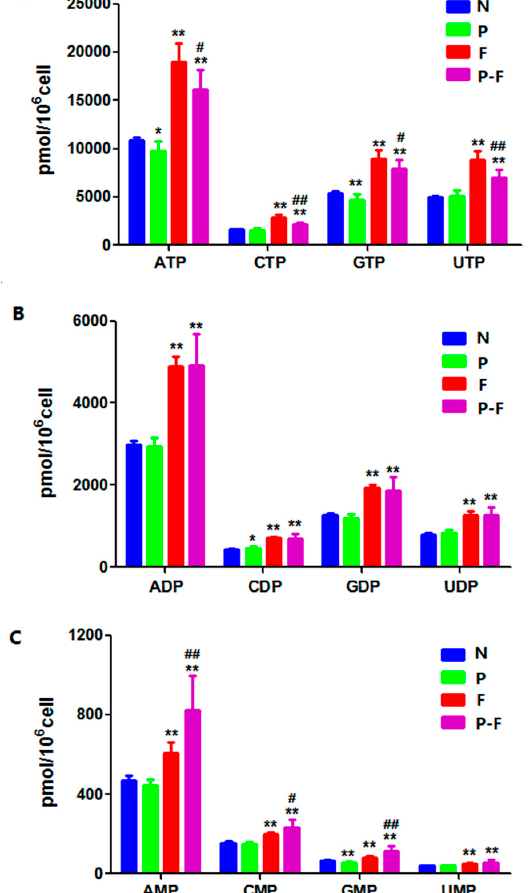
Figure 3. Levels of ribonucleotides in HepG2 cells after treatment with drugs for 24 h: ( A ) nucleoside triphosphate levels in every group; ( B ) nucleoside diphosphate levels in every group; and ( C ) nucleoside monophosphate levels in every group. Each group of data are represented as mean ± SD of three independent experiments. * p < 0.05 and ** p < 0.01, compared with the control group; # p < 0.05 and ## p < 0.01, compared with the 5-FU group.